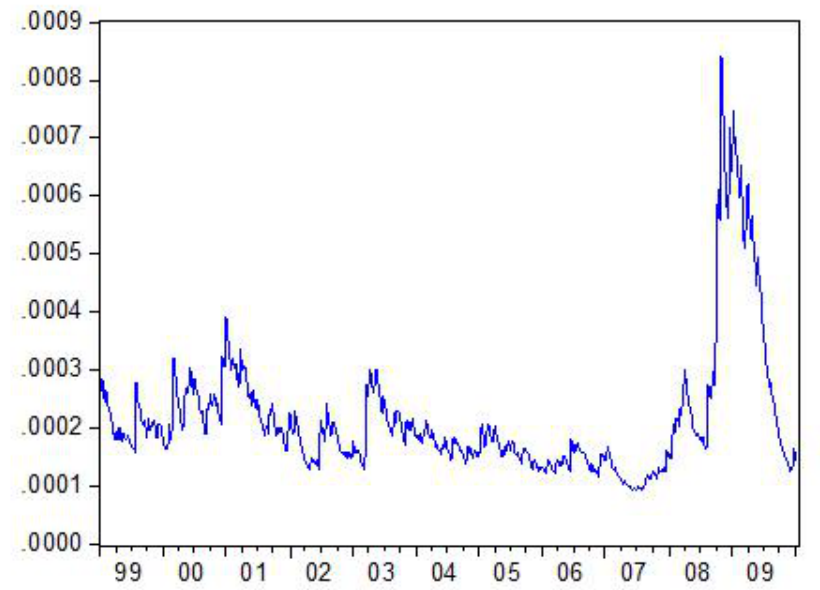
Fig. 2: GARCH(1,1) estimate of the variance of the dollar-Euro exchange